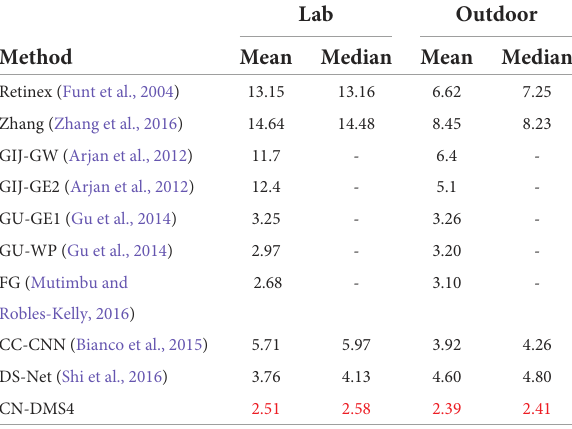
TABLE 1 Quantitative evaluation on the Gijsenij dataset (Arjan et al., 2012), red indicates the best.